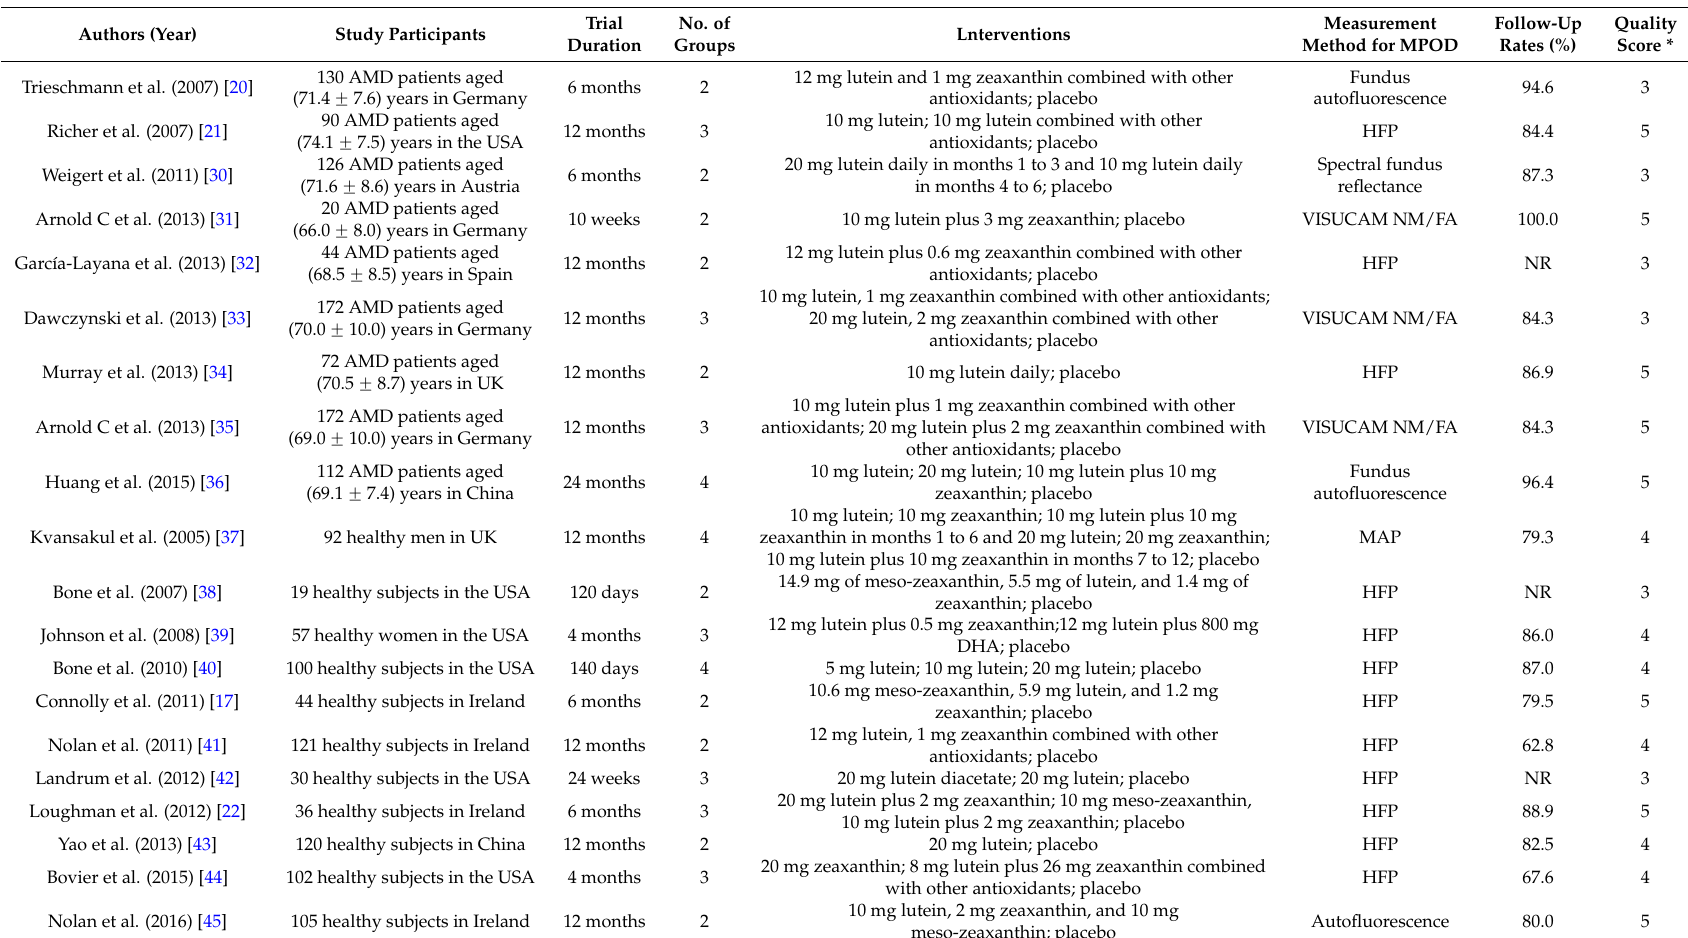
Table 1. Characteristics of the eligible randomized clinical